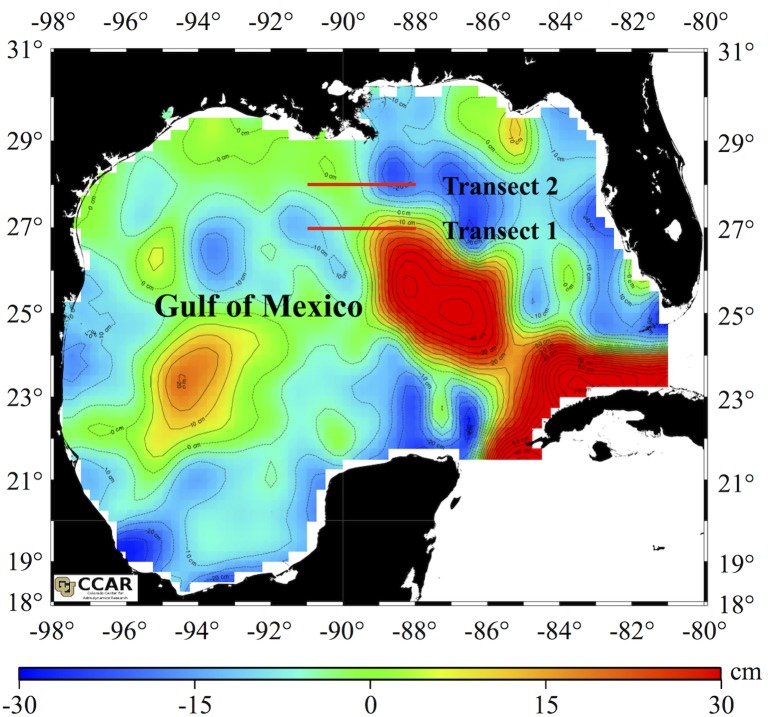
Map of the Gulf of Mexico showing the sea surface height anomaly (SSH) (cm).Cyclonic features are represented by cooler colors indicating negative SSH, while the anti-cyclonic loop current is represented by warmer colors indicating positive SSH. Black dashed lines delineate contours of similar SSH at intervals of 10 cm. Sampling transect 1 and 2 are highlighted in red lines.